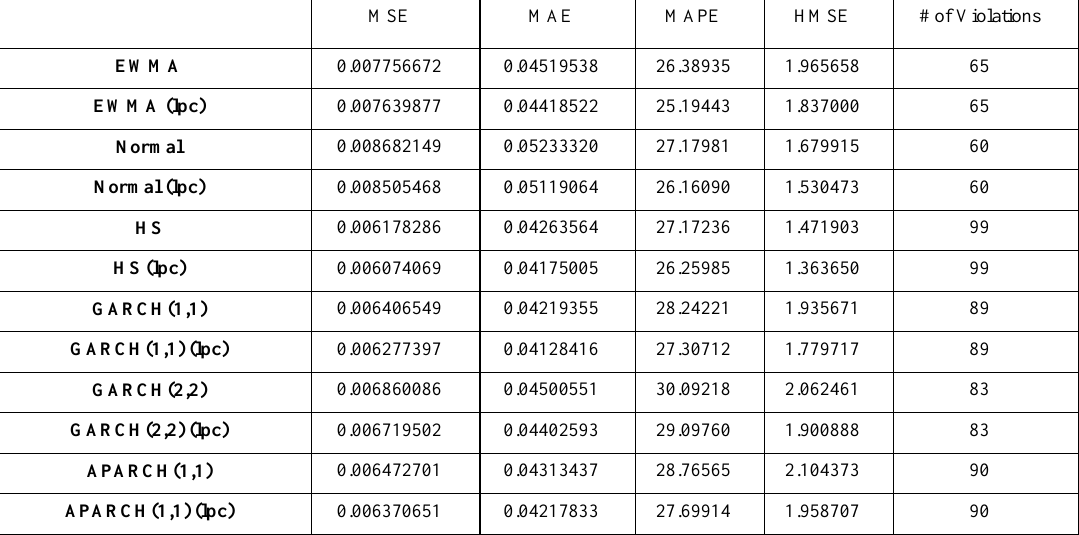
Table 8. Standard evaluation measures results for PVaR with and without lpc of NAK – 3 MSE MAE MAPE